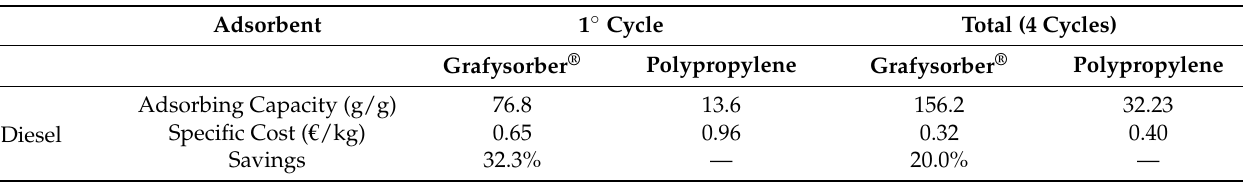
Table 6. Indicative costs for the recovery of 1 kg of the various oils considered by using Grafysorber ® G+ and